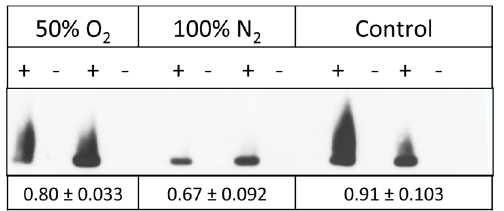
Figure 4. Biotin switch analysis of trout hearts indicates changes in Mb-SNO levels following incubation of trout heart preparations in oxygenated and anoxic conditions. Three freshly isolated ventricle rings were prepared from a single heart and either directly frozen (control) or incubated for 45 minutes in the presence (50% O 2 ) or absence (100% N 2 ) of O 2 . Following incubation, the rings were immediately frozen. Lysates were prepared from heart rings and analyzed by the biotin switch technique. Samples labeled in the presence of NEM-Biotin are marked as + , while those in which biotin was omitted ( 2 ) serve as individual controls. Image shows rings isolated from two separate hearts. Biotin-labeled Mb was quantified by densitometry and then normalized to the total protein content. The mean 6 standard error Mb-SNO level (n=5) is given below the figure.